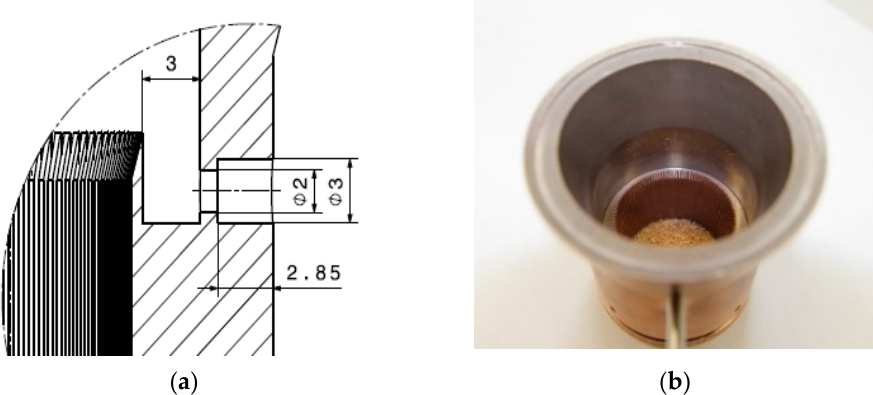
Figure 4. Inner view of HPEE mock-up: ( a ) illustration of the reservoir; ( b ) manufactured grooves and sintered porous evaporator.